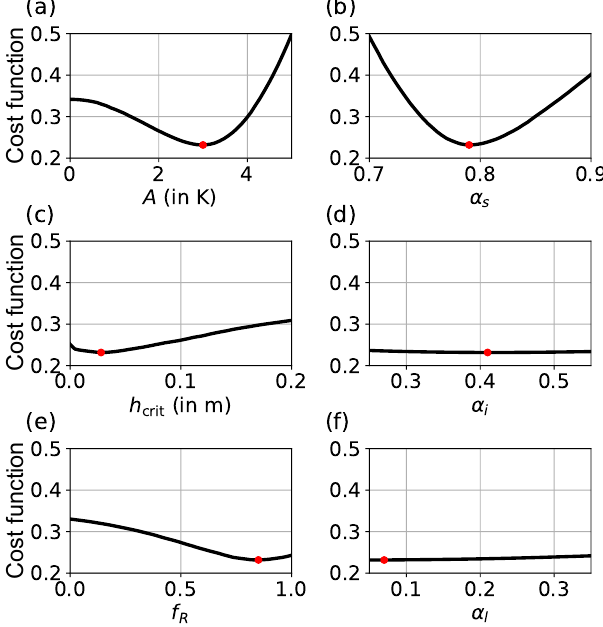
Figure 8. Sensitivity of cost function J , Eq. (20), for each of the free model parameters listed in Table 3: the diurnal cycle amplitude A (a) , the snow albedo α s (b) , the critical snow height h crit (c) , the bare ice albedo α i (d) , the refreezing correction parameter f R (e) , and the bare land albedo α l (f) . The red dot in each plot indicates the optimum as obtained by the calibration, i.e. the particle swarm